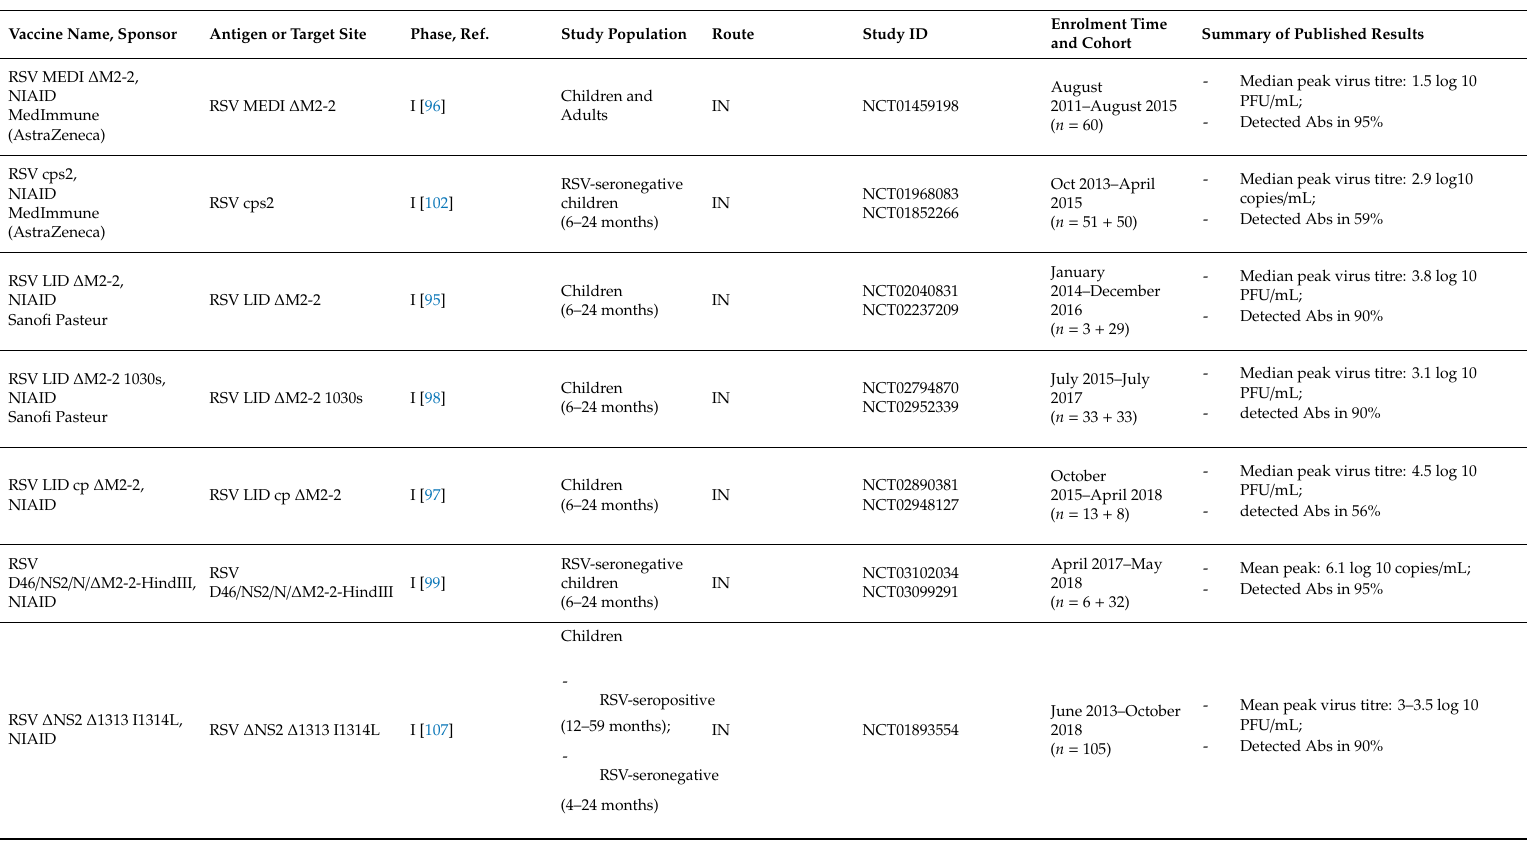
Table 5. Overview of the RSV live-attenuated or chimeric vaccines in clinical development. Ab: antibody; ADA: anti-drug antibody; AE: adverse event; Ag: antigen; CI: confidence interval; CHD: congenital heart defect, CLD: chronic lung disease; COPD: chronic obstructive pulmonary disease; Corp: corporation; f.up: follow-up; GA: gestational age; IM: intramuscular; IN: intranasal; IV: intravenous; LRTD: lower respiratory tract disease; LRTI: lower respiratory tract infection; mAb: monoclonal antibody; NA: not available; NIAID: National Institute of Allergy and Infectious Diseases; PCA: palivizumab-competing antibody; PFU: plaque-forming units; PIV3: Parainfluenza Virus type 3; Ref: reference; RSV: respiratory syncytial virus; RT-PCR: reverse transcriptase polymerase chain reaction; SAE: serious adverse event; TCID 50 : Tissue Culture Infectious Dose 50%; vs.: